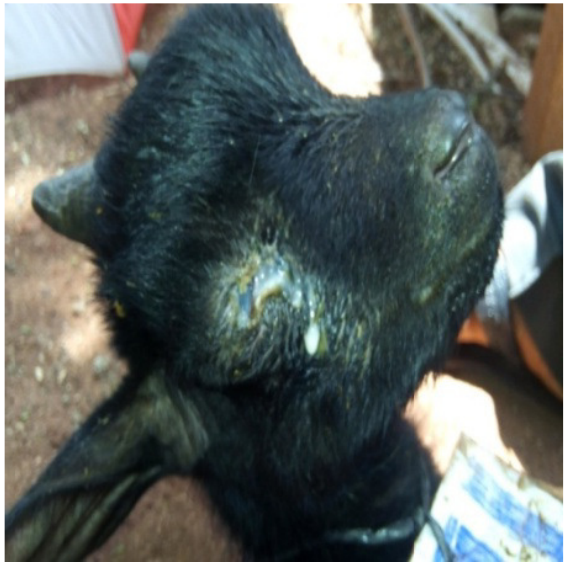
Fig. 1. A WAD goat suffering from PPR showing mucopurulent ocular